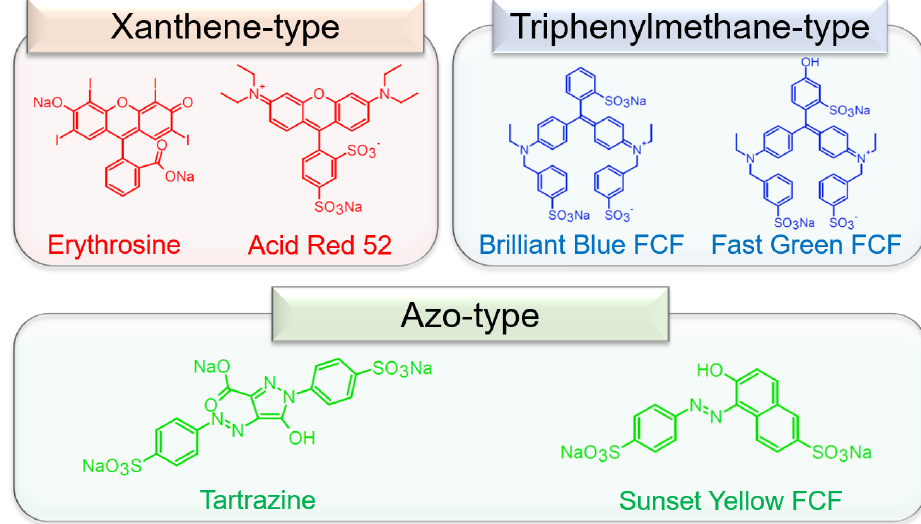
Figure 1. The molecular structures of the tar dyes.